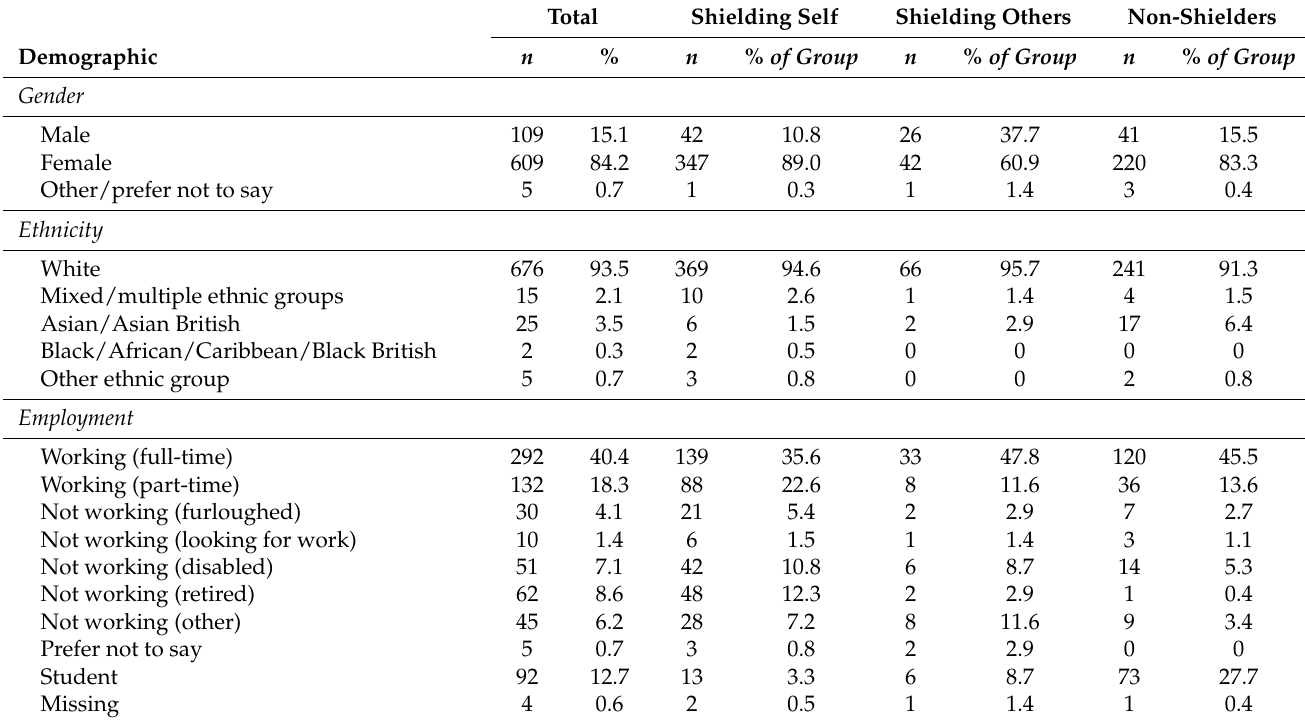
Table 1. Demographics for all included